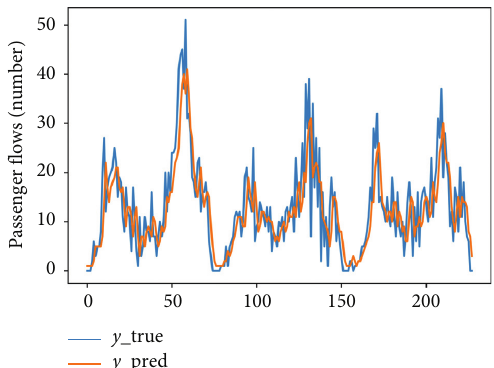
Figure 9: Regression integration prediction results when the time step is 30